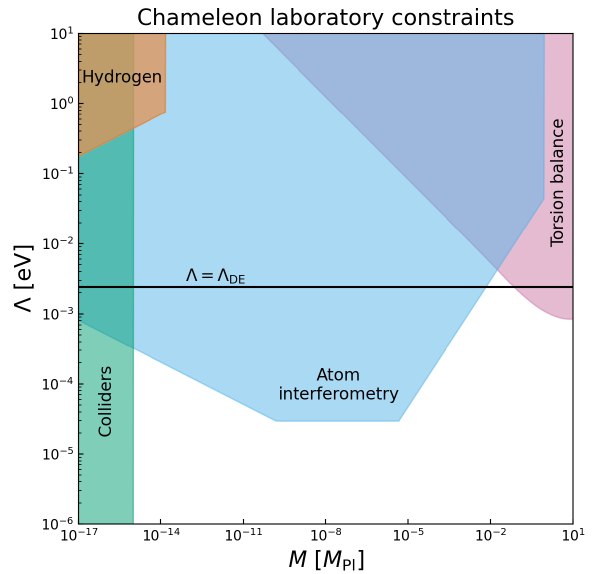
Figure 1. Current bounds on n = 1 chameleon theory parameters from various